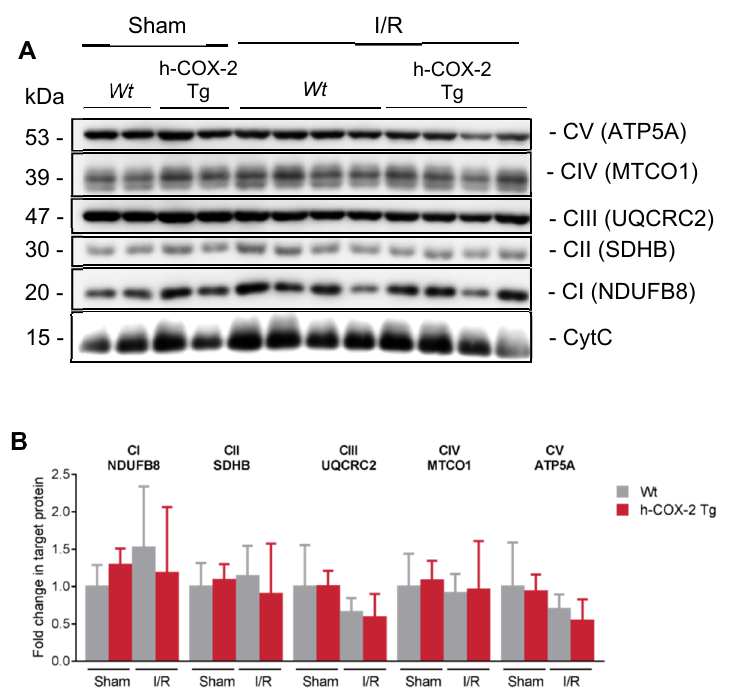
Figure 2. Analysis of the protein content of the electron transport chain (ETC) in liver-isolated mitochondria from Wt and h-COX-2 Tg mice after Sham or I/R surgery. ( A ) Representative western blot of one subunit of each mitochondrial ETC complex (ATP5a for CV, MTCO1 for CIV, UQCRC2 for CIII, SDHB for CII and NDUF8 for CI). Cytochrome C (CytC) was used as a loading control. ( B ) Densitometry analysis of the OXPHOS Western Blot. Bars are means ± SD of 4–9 independent measures. Statistical test: one-way ANOVA, followed by Tukey’s posthoc test.